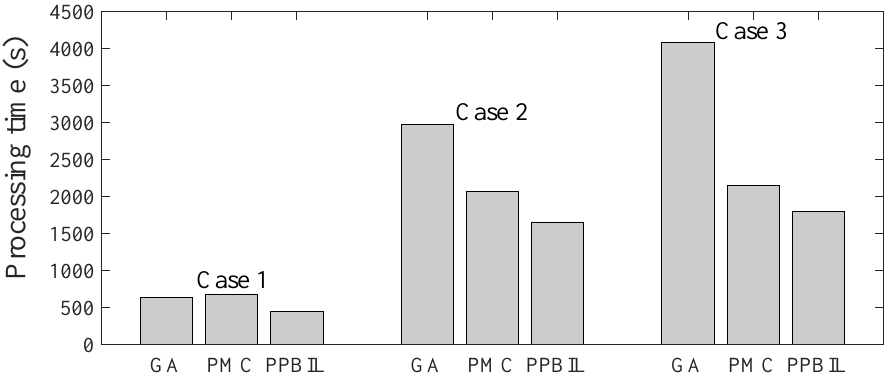
Figure 12. Processing time of the 33 bus test system: GA, PMC and